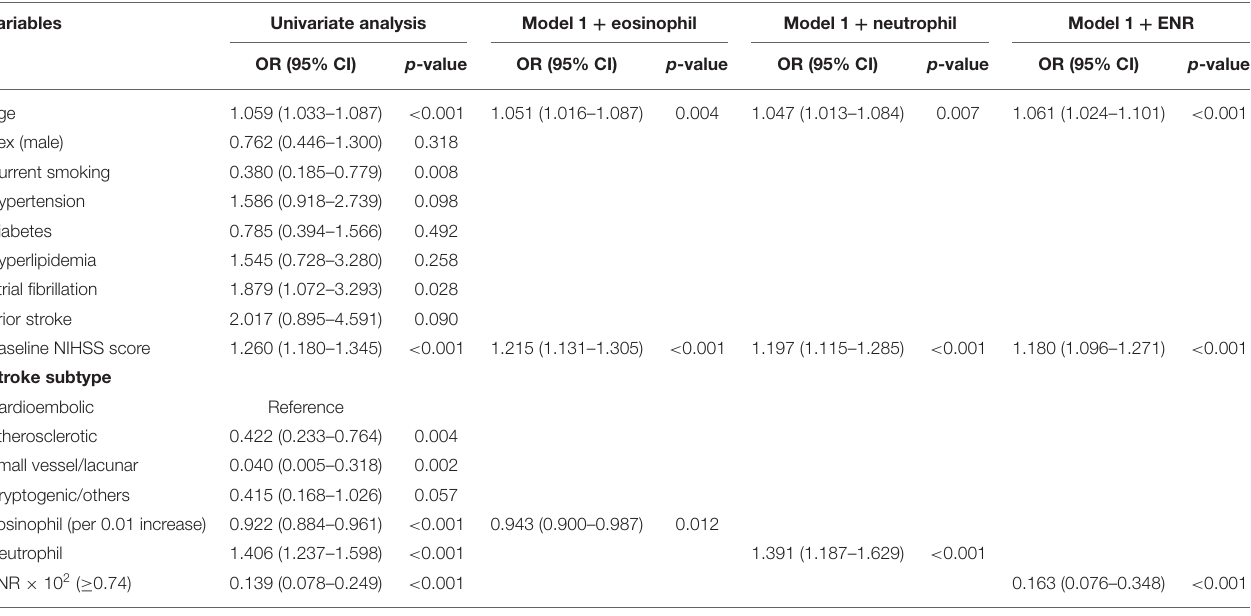
TABLE 3 | Univariate and multivariate logistic regression analysis for 3-month poor